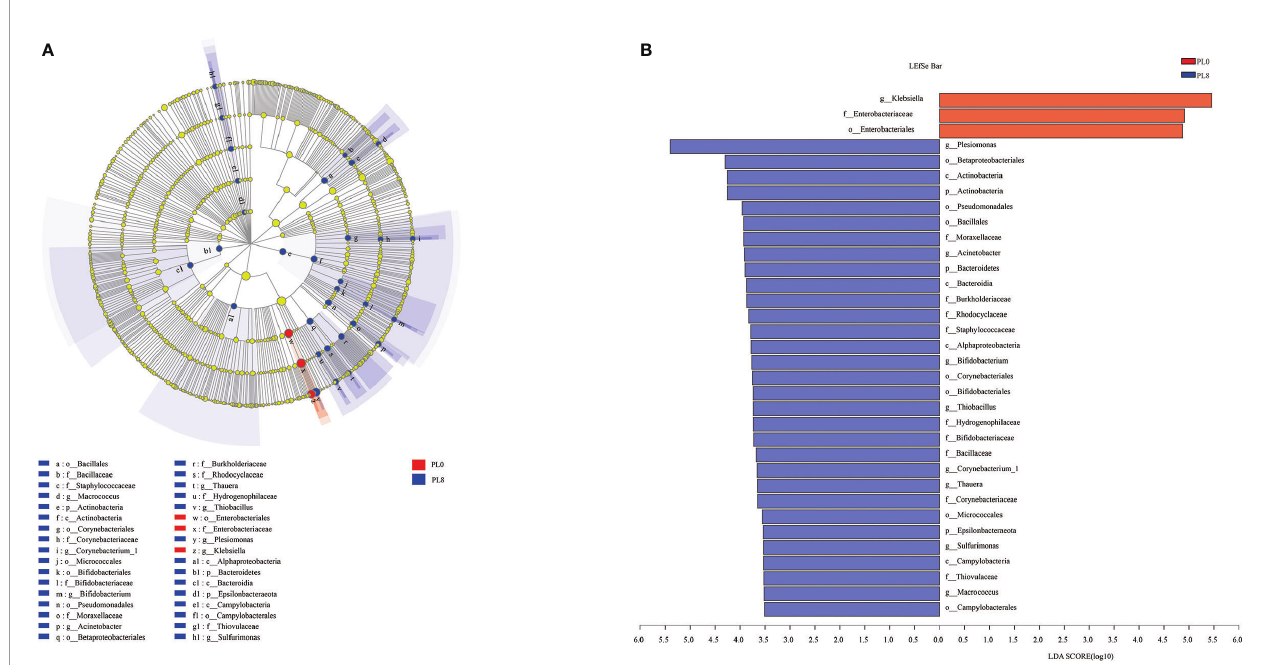
FIGURE 10 | Cladogram showing the phylogenetic distribution of the bacterial lineages associated with dietary phospholipids inclusion. Taxonomic representation of statistically and biologically consistent differences between intestinal microbiota of largemouth bass in the PL0 (control) and PL8 groups (A) . Differences were represented by the color of the most abundant class (red indicates the control group; blue indicates PL8 group). Histogram of linear discriminant analysis (LDA) scores for differentially abundant taxon (B) . For interpretation of the references to color in this fi gure legend, the reader is referred to the web version of this